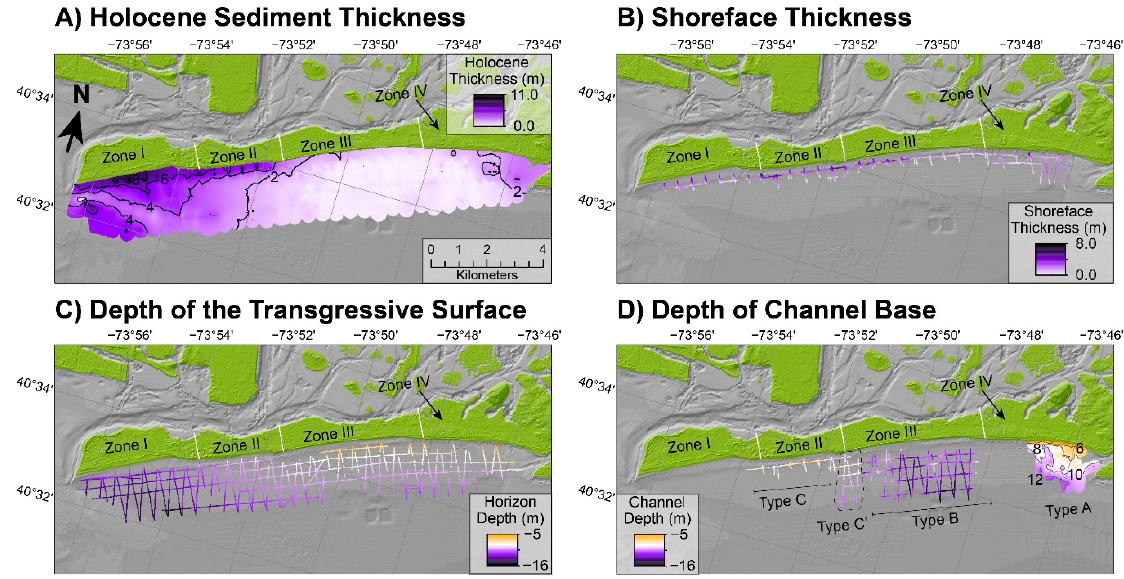
Figure 12. Isopach and Structure maps. ( A ) Interpolated thickness map of Holocene sediment. ( B ) Thickness of Shoreface sediment. ( C ) Structure map of the depth of the transgressive surface. ( D ) Structure map of the depth of Type C, C’, B, and A channels. White lines on the peninsula delineate the boundaries of the geomorphic zones.